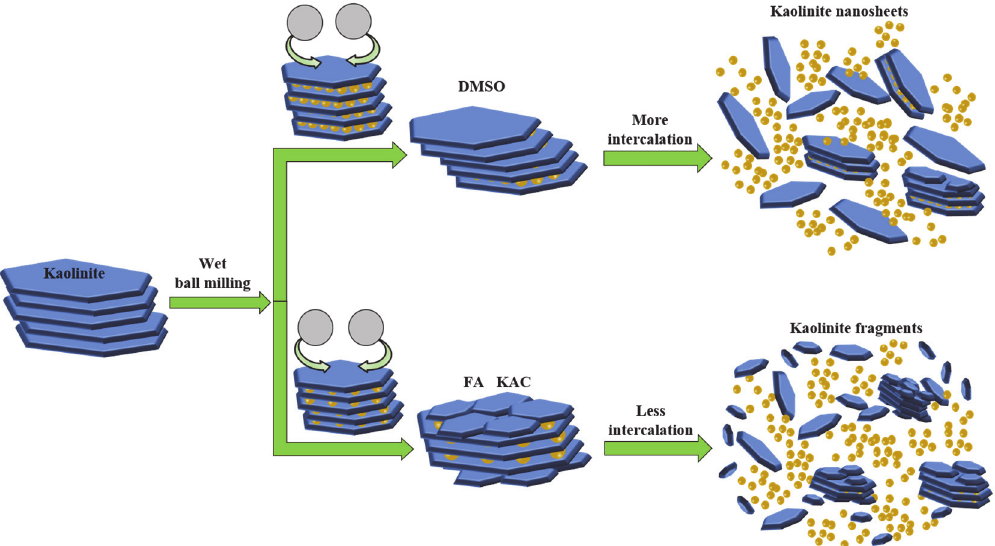
Figure 10. Intercalation effect and mechanism of kaolinite in different solvents with wet ball mill ‐ ing.